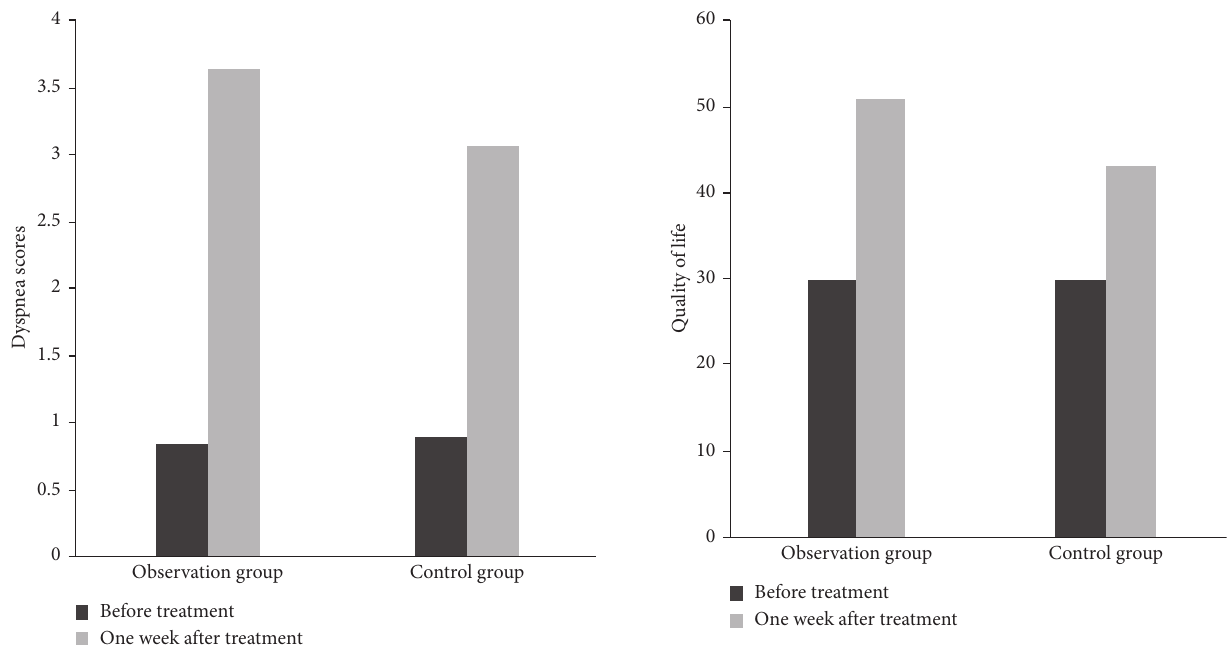
Figure 5: Comparison of quality of life between the two groups. Note: compared with the same group before treatment ( a P < 0 . 05) and the control group after treatment ( b P < 0 .